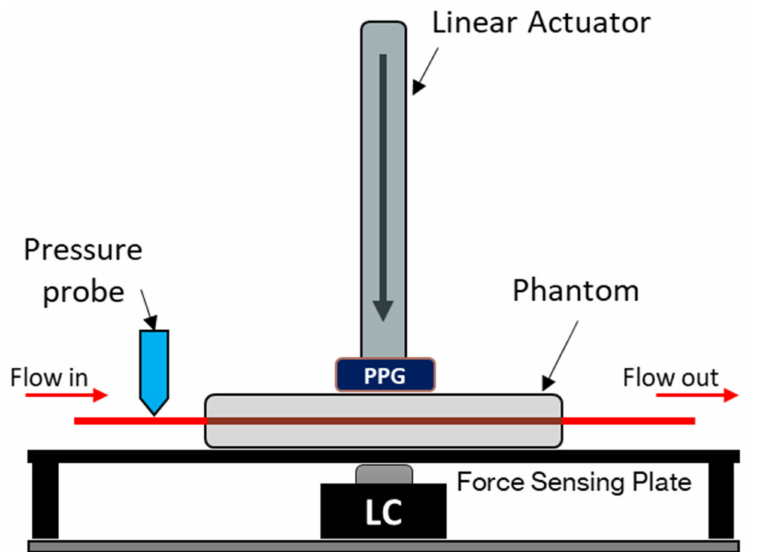
Figure 1. In vitro force-sensing setup. The PPG sensor (dual-wavelength, 660 nm and 940 nm) is mounted on the end of the linear actuator. The vascular tissue phantom rests on top of a force-sensing plate with a 50 N load cell (LC) as the force measuring device. A blood-mimicking fluid is pumped from the artificial vessel network, and the blood pressure is measured at the input of the phantom. The sensor position is measured from the surface of the phantom, where a positive increase indicates how much the sensor has descended into the